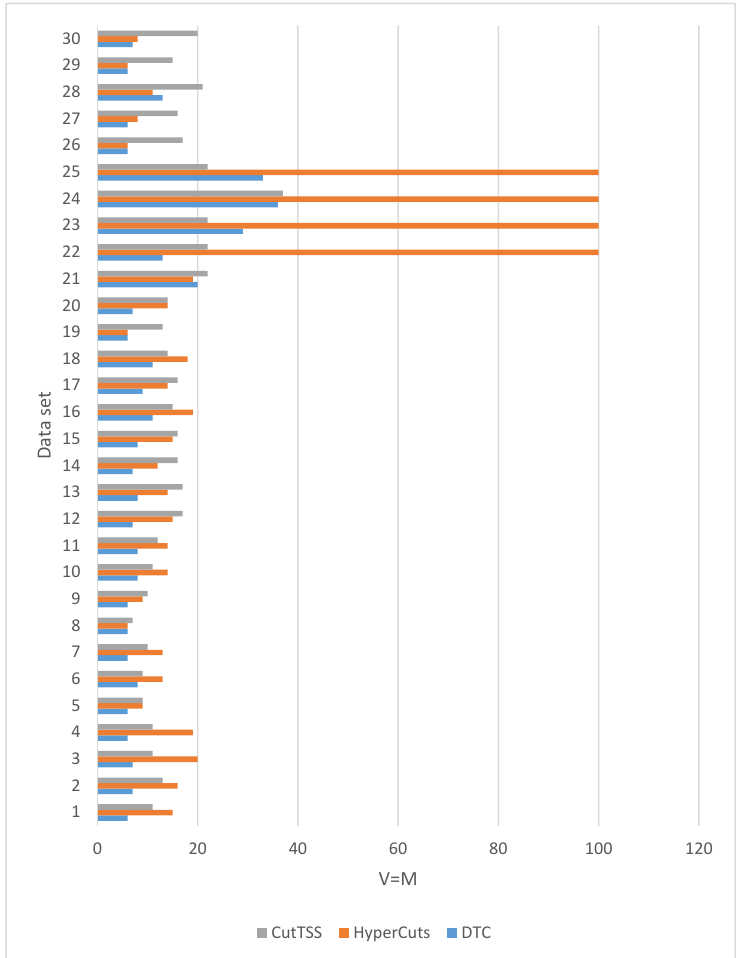
Figure 8. The experimental result when V = M (memory overhead).